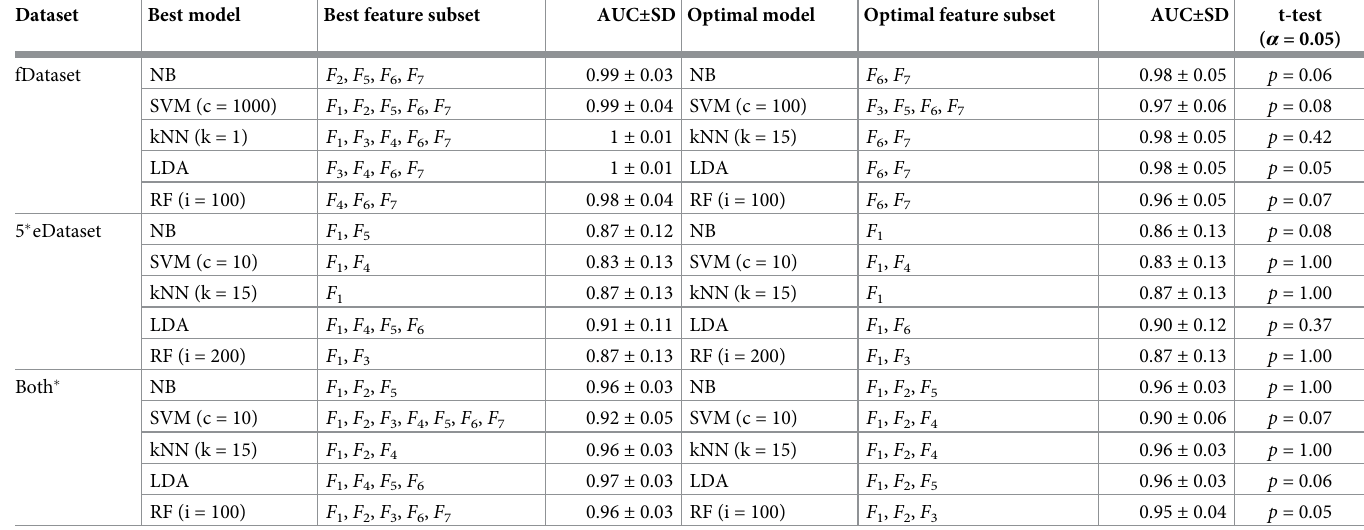
Table 2. Summary of the statistical comparison based on the AUC performance between the best and optimal feature subset per classifier. Dataset Best